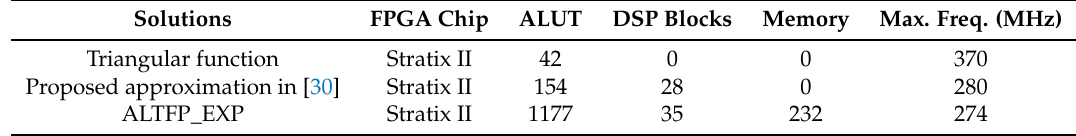
Table 4. Resource consumption of Tribas versus Exponential